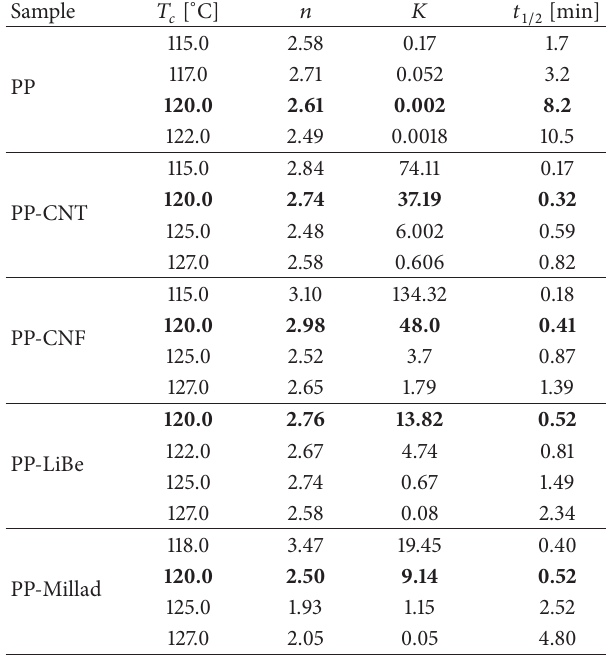
Table 4: Crystallization temperature 𝑇 𝑐 , Avrami’s constant 𝐾 , Avrami’s exponent 𝑛 , and crystallization half-life time 𝑡 1/2 for PP at different temperatures. In all cases, the nucleating agent concentration was 0.1 wt%.